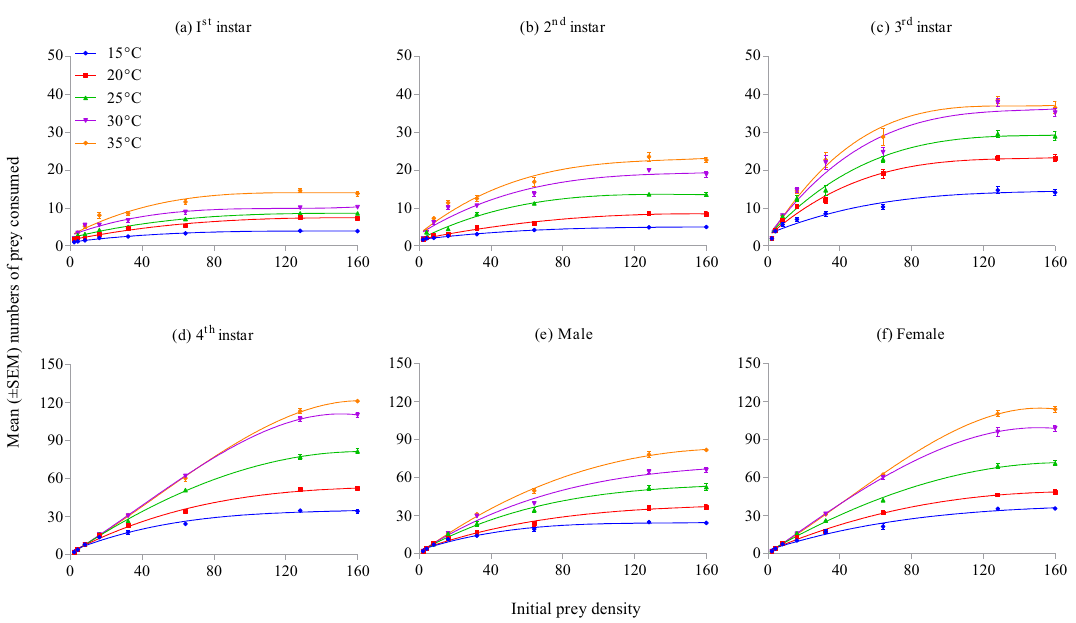
Figure 5. Type II functional response curves fitted by Roger’s random predator equation of Harmonia axyridis under different densities of Acyrthosiphon pisum over a 24 h period, under different thermal